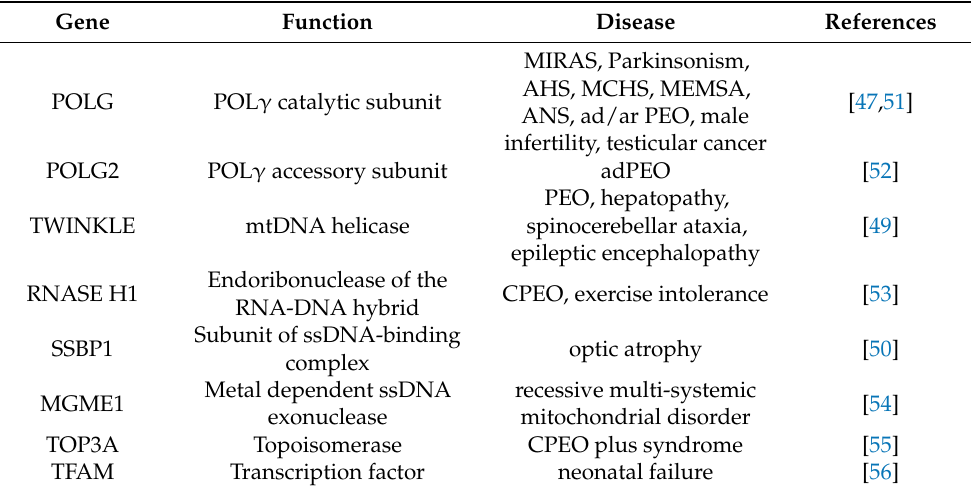
Table 1. Diseases caused by mutations of the proteins regulating mtDNA